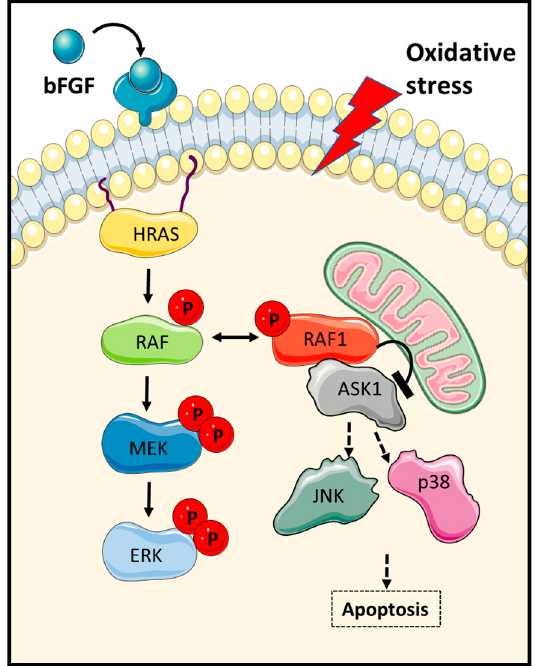
Figure 2. RAF1 kinase-independent regulation of ASK1 proapoptotic signalling. FGF activation promotes RAF1–ASK1 complex localization in the mitochondria. Oxidative stress prevents the inhibitory binding of RAF1 to ASK1 and leads to activation of stress MAPK.